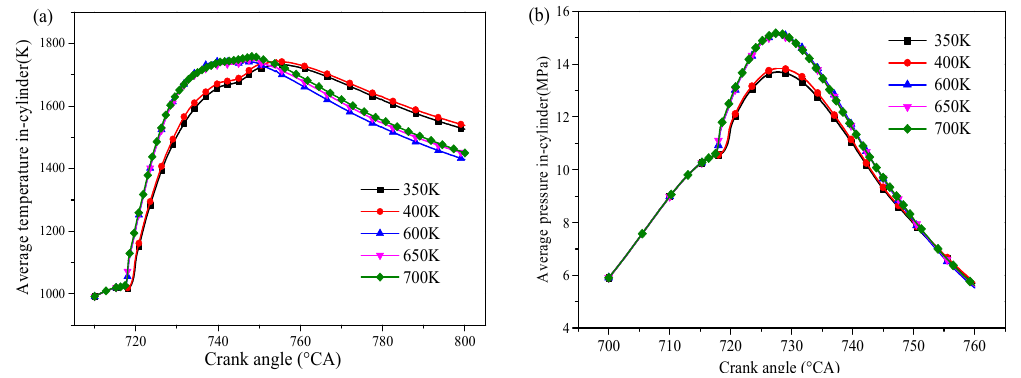
Figure 4. Change curve of parameters in cylinder at different time. (a) average temperature; (b) average pressure.